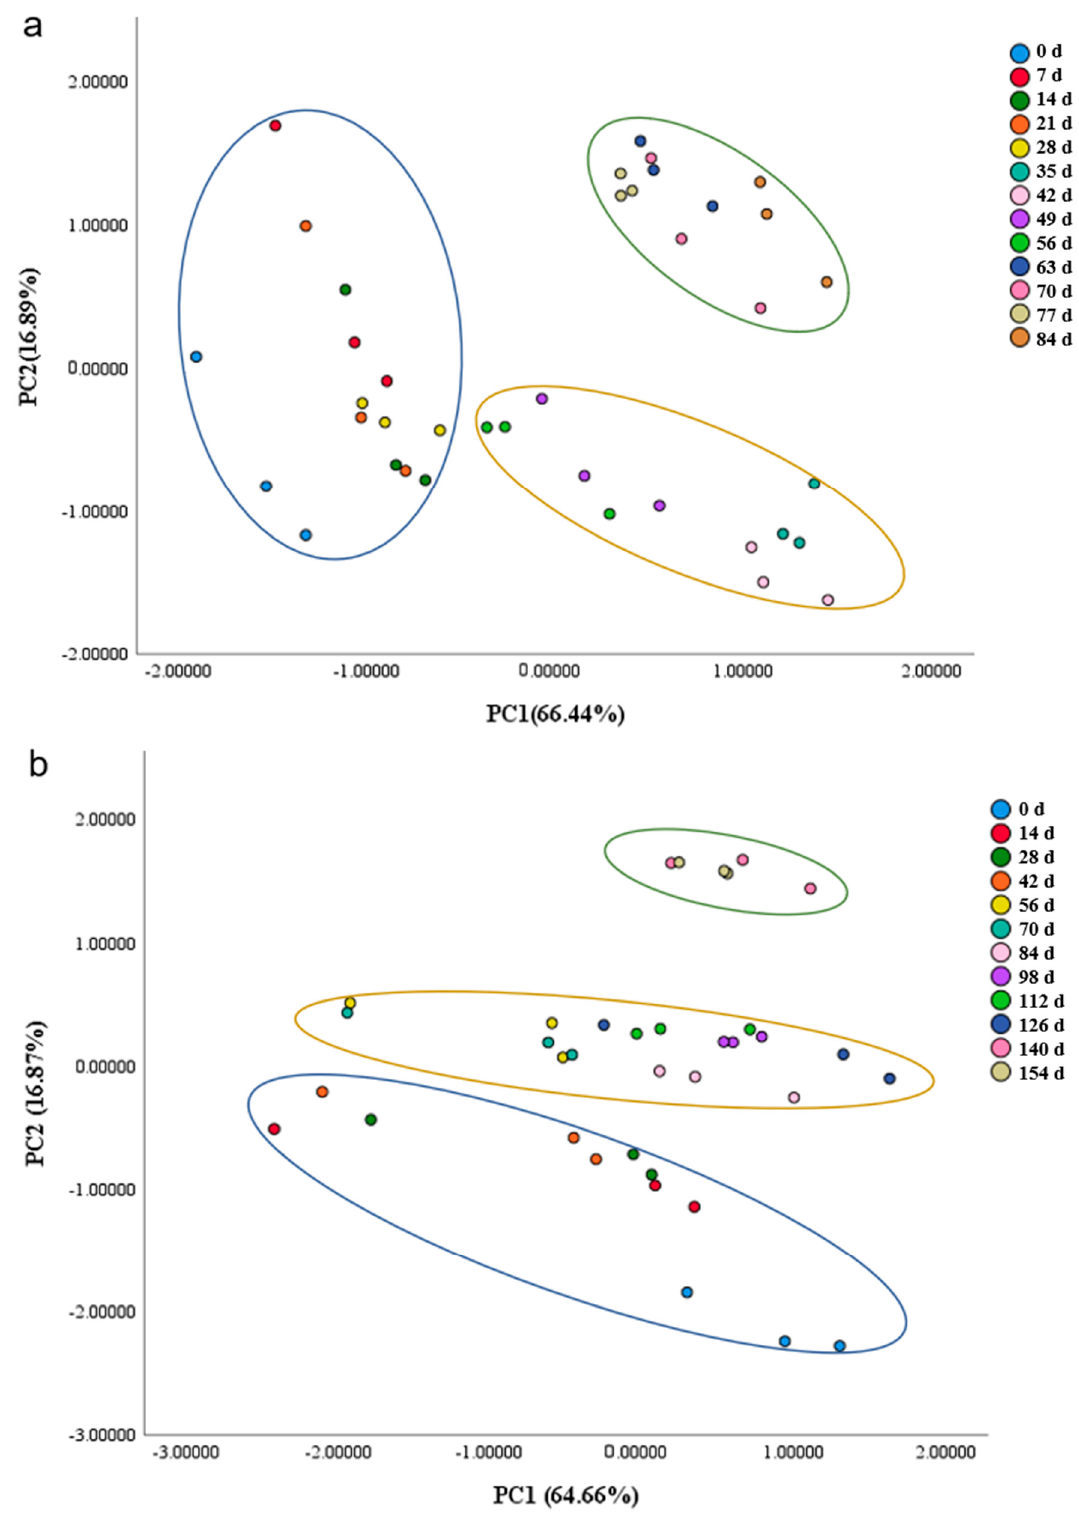
Figure 4. ( a ) PCA analysis of Sichuan sauerkraut during storage at 45 °C. ( b ) PCA analysis of Sichuan sauerkraut during storage at 35 °C.